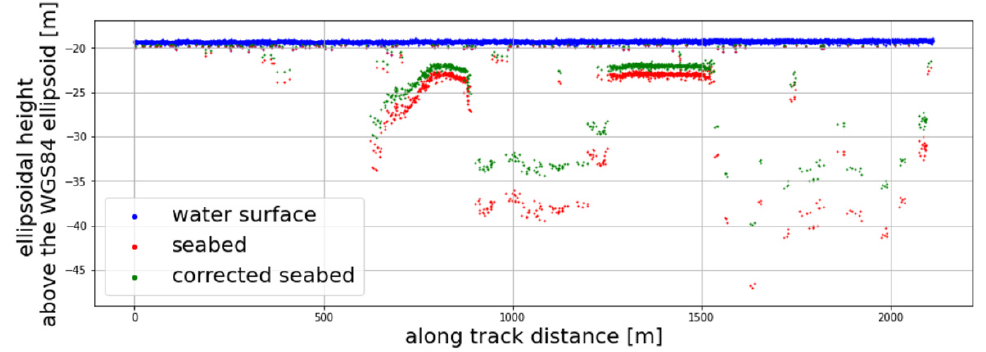
Figure 6. Point clouds of the ICESat-2 signal acquired on 14 May 2020. The signal was processed to remove the noise, correct for refraction, and identify the seafloor. Uncorrected seafloor photons appear in red, while corrected photons are in